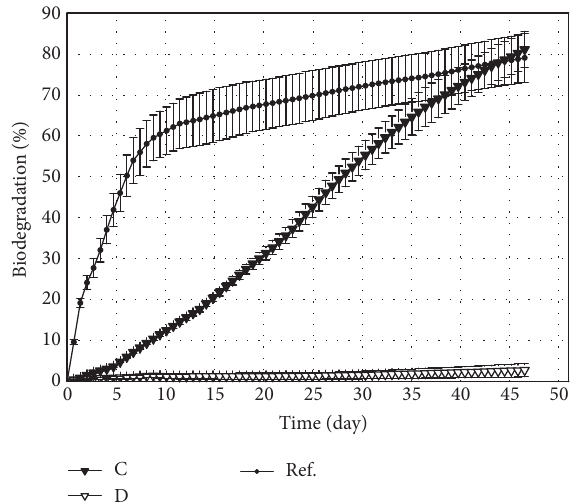
Figure 6: Second biodegradation trial: cumulated CO 2 emissions per vessel. (C) PLA/PBAT blend; (D) polyethylene film, negative reference; (Ref) reference, cellulose. Error bars refer to standard error ( 𝑛 = 3 ).